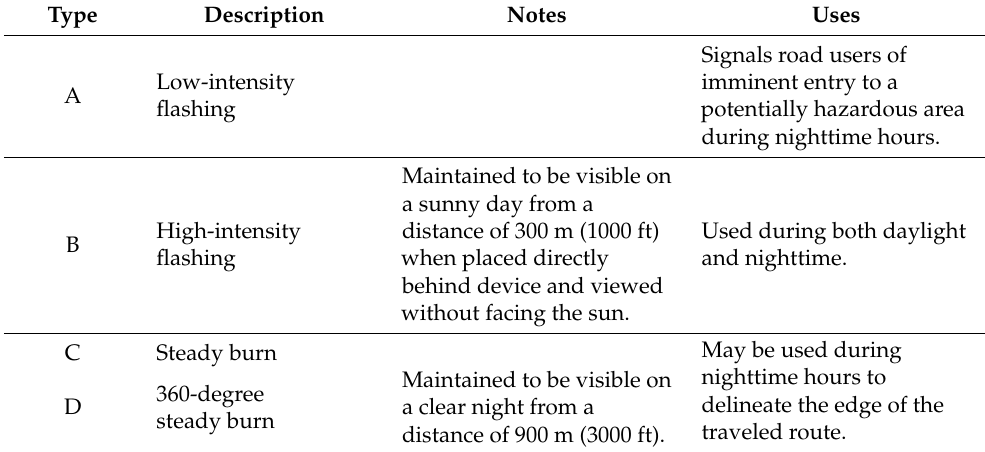
Table 3. Categories and applications of 360-degree warning lights